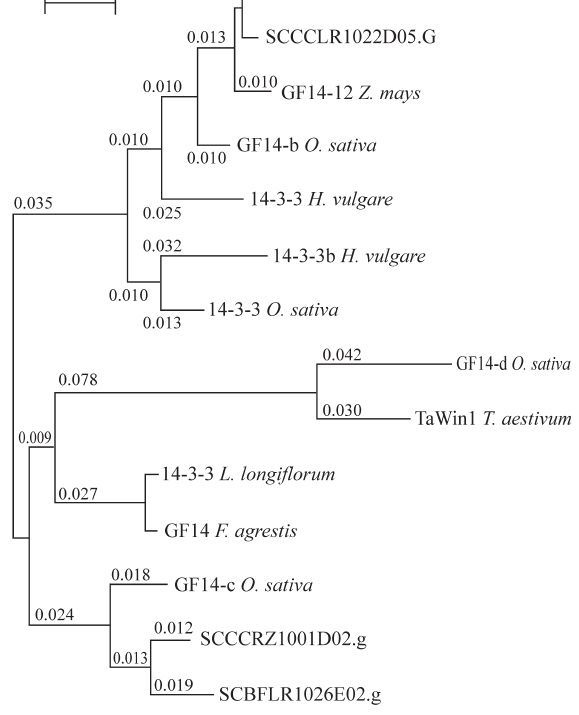
Figure 3 - Dendrogram showing the distance relationships between 14-3-3 amino acid sequences of sugarcane clusters SCCCLR1022D05.g, SCCCRZ1001D02.g and SCBFLR1026E02.g and 14-3-3 proteins of mai- ze, rice and barley. The sequence distance tree was calculated using the neighbor-joining